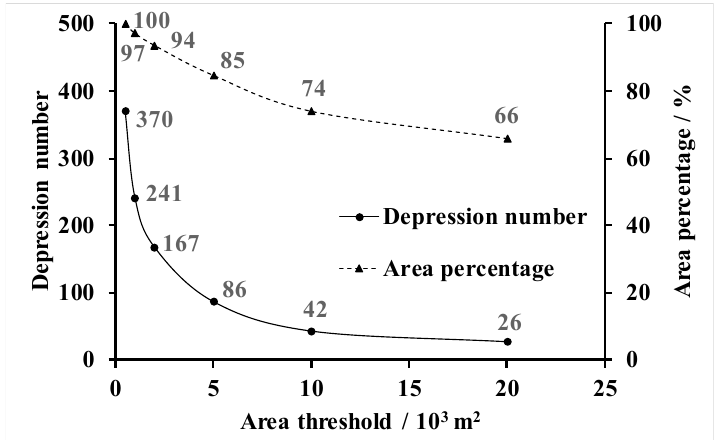
Figure 4. The changes in the number and area percentage of depressions at area thresholds of 500, 1000, 2000, 5000, 10,000, and 20,000 m 2 . The area percentage is 100 when the area threshold is 500 m 2 .